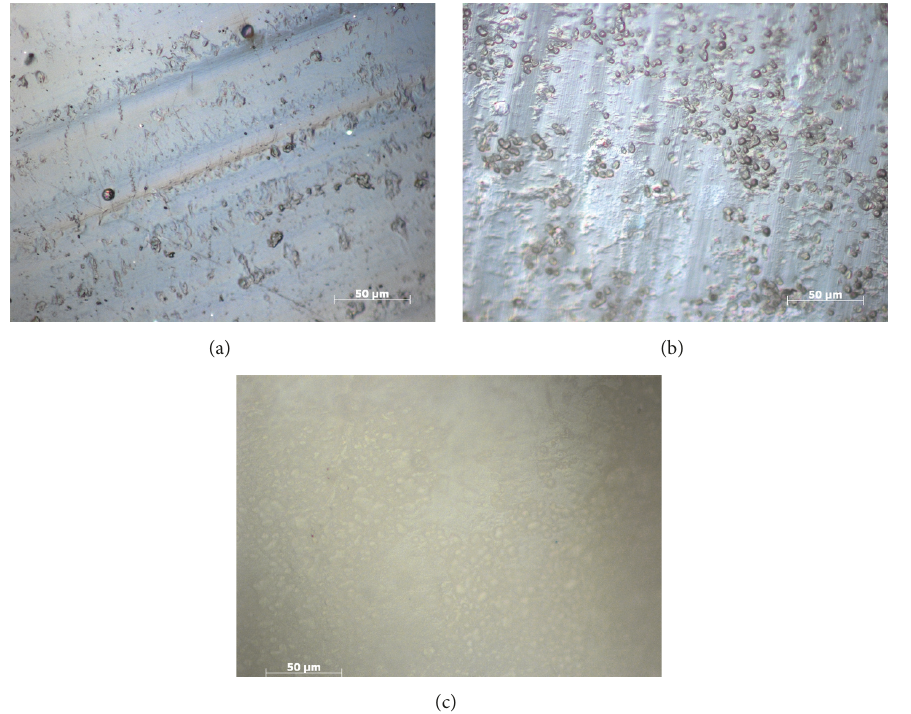
Figure 8: Micrographs (OM) of the samples: (a) PLA; (b) PLA, 14 days; (c) PLA, 28 days of in vivo testing.